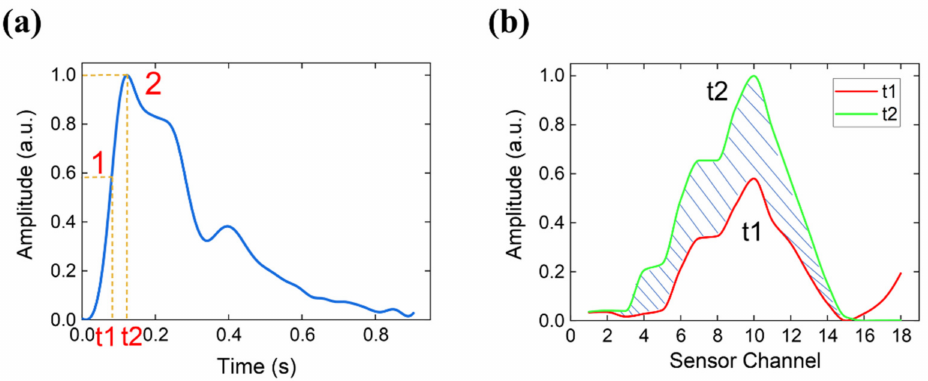
Figure 14. ( a ) Typical pulse waveform within a pulse period. ( b ) Curves formed by signals from all sensors sampled at different time points.